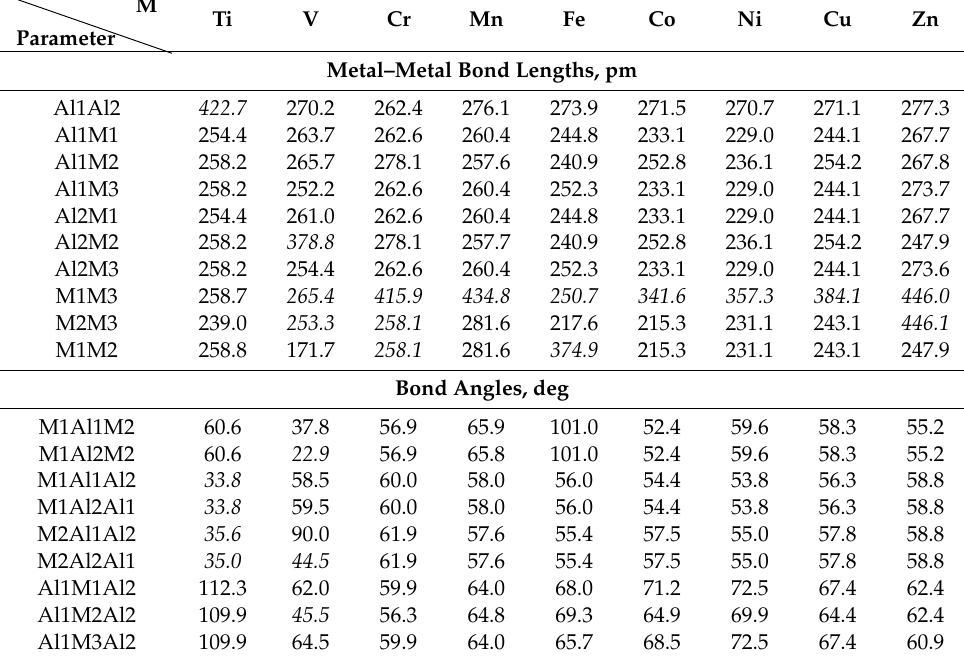
Table 5. Key structural parameters of most stable Al 2 M 3 clusters (M—3 d -element) [92,93] *. M